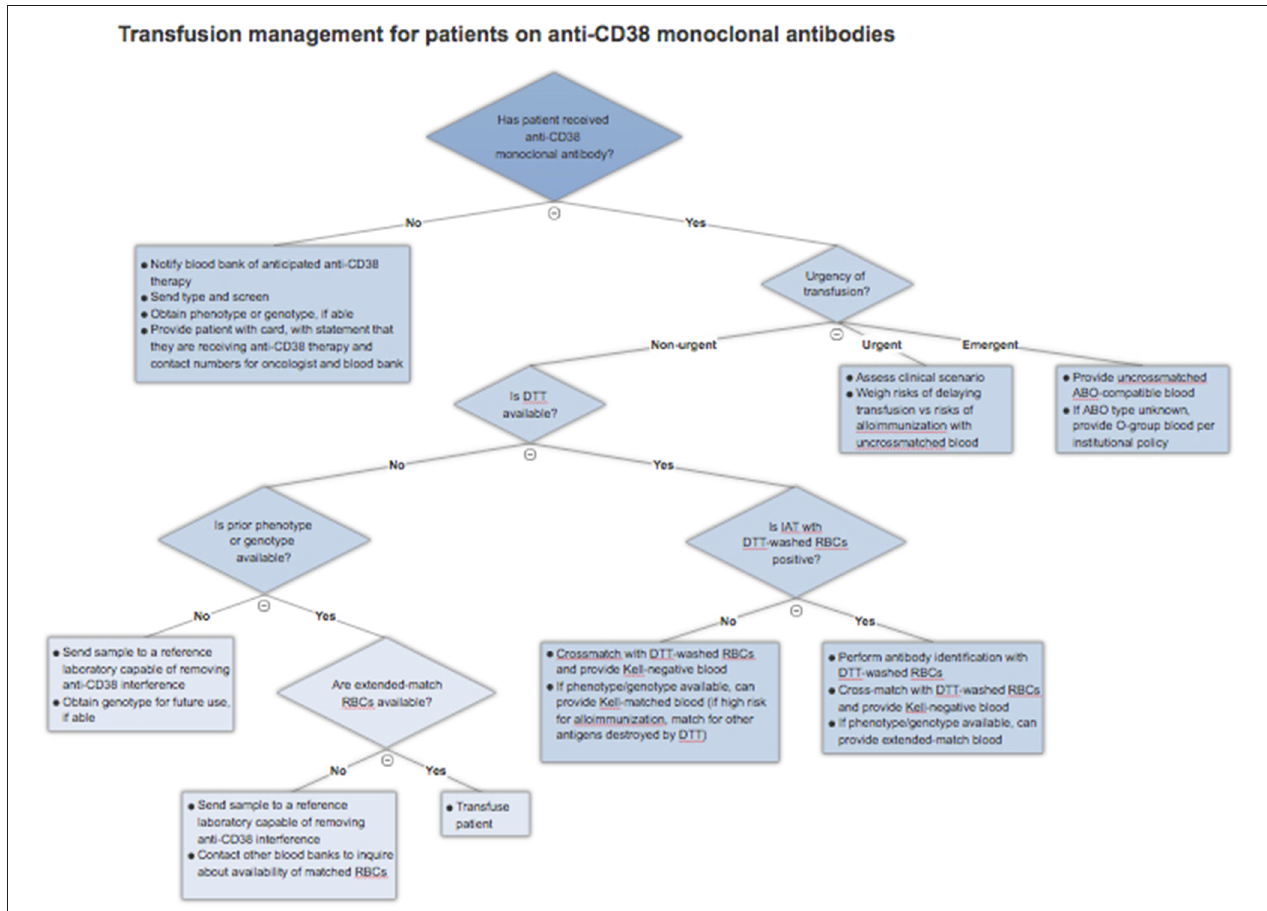
FIGURE 2 | Blood transfusion management algorithm for patients treated with anti-CD38 monoclonal antibodies.